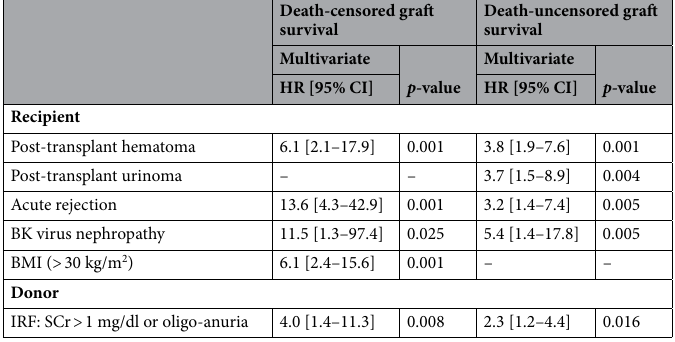
Table 5. Multivariable Cox regression model for risk factors of death-censored and death-uncensored graft loss in the overall population. All variables with a p-value under 0.2 in univariate analyses were introduced in the multivariate models. For all tests, a p-value < 0.05 was considered as significant. BMI Body Mass Index, SCr serum